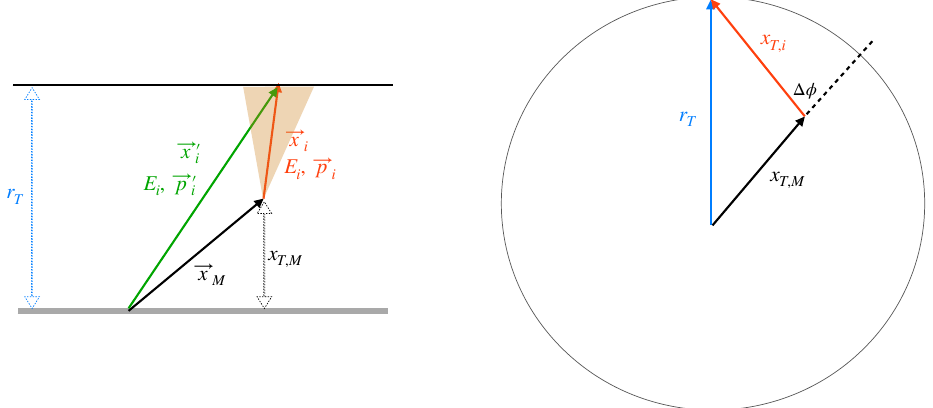
Figure 2 . The mother particle M travels along ~x M and decays to a delayed jet (shaded brown). The daughter particle i travels along ~x identified then i is assumed to have traveled along ~x